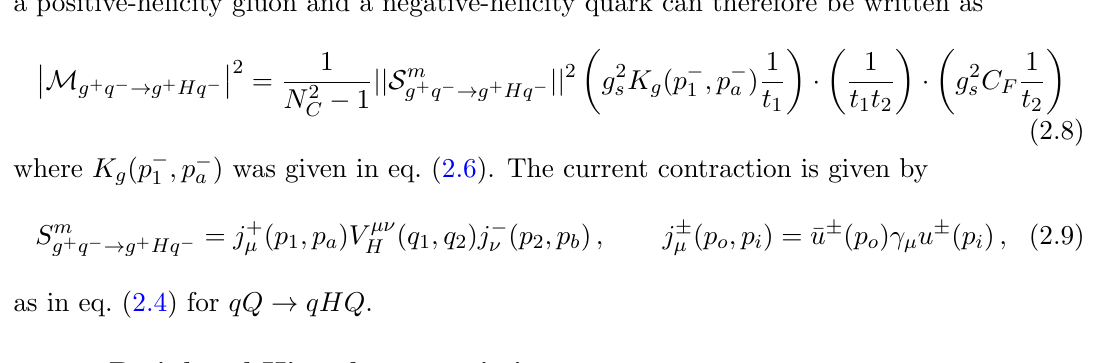
Figure 2 . Leading-order diagrams contributing to the process gq wise fermion (cid:13)ow in the heavy quark loop can be obtained via charge conjugation and are not